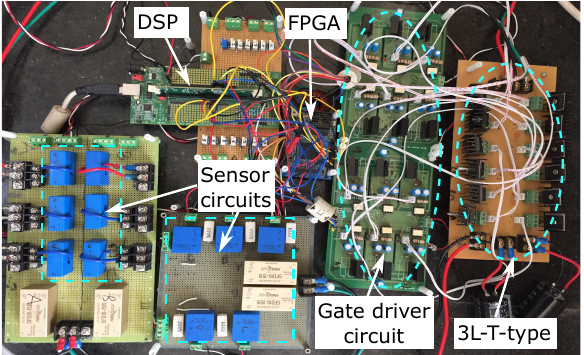
Figure 13. Experimental prototype in the